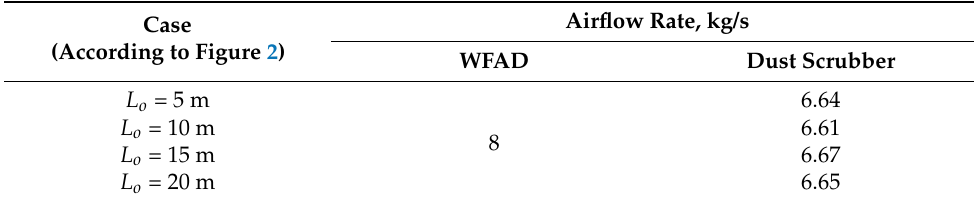
Table 1. Assumptions for CFD calculations.